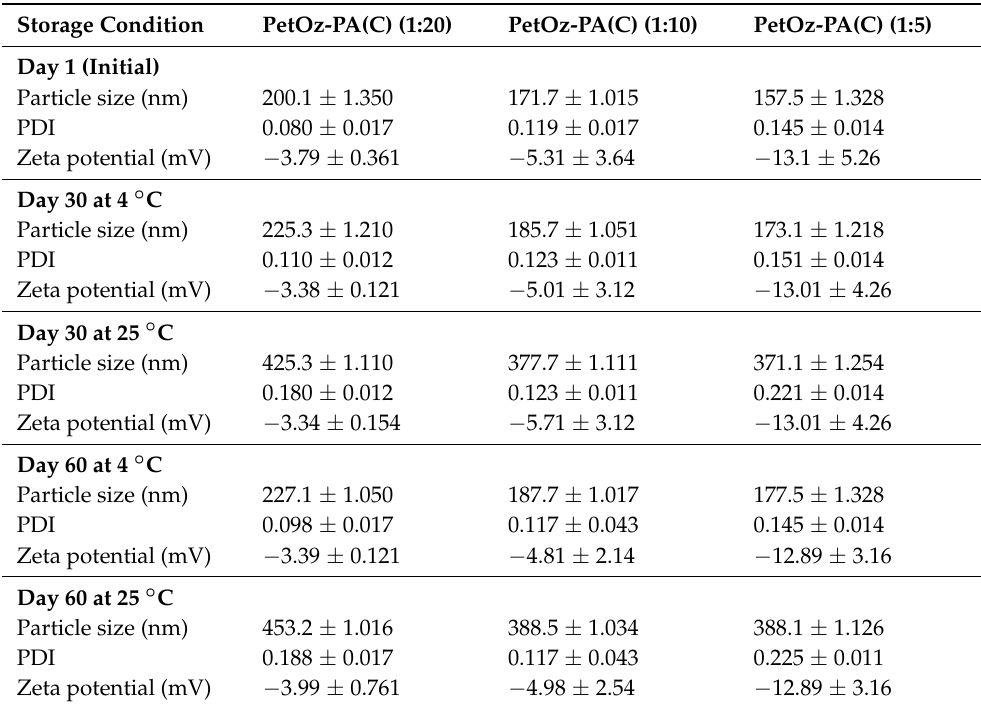
Table 1. Size distribution and surface charge of PetOz-PA(C) (1:20; 1:10 and 1:5) stored at 25 ◦ C and 4 ◦ C at day 1, 30, and 60.